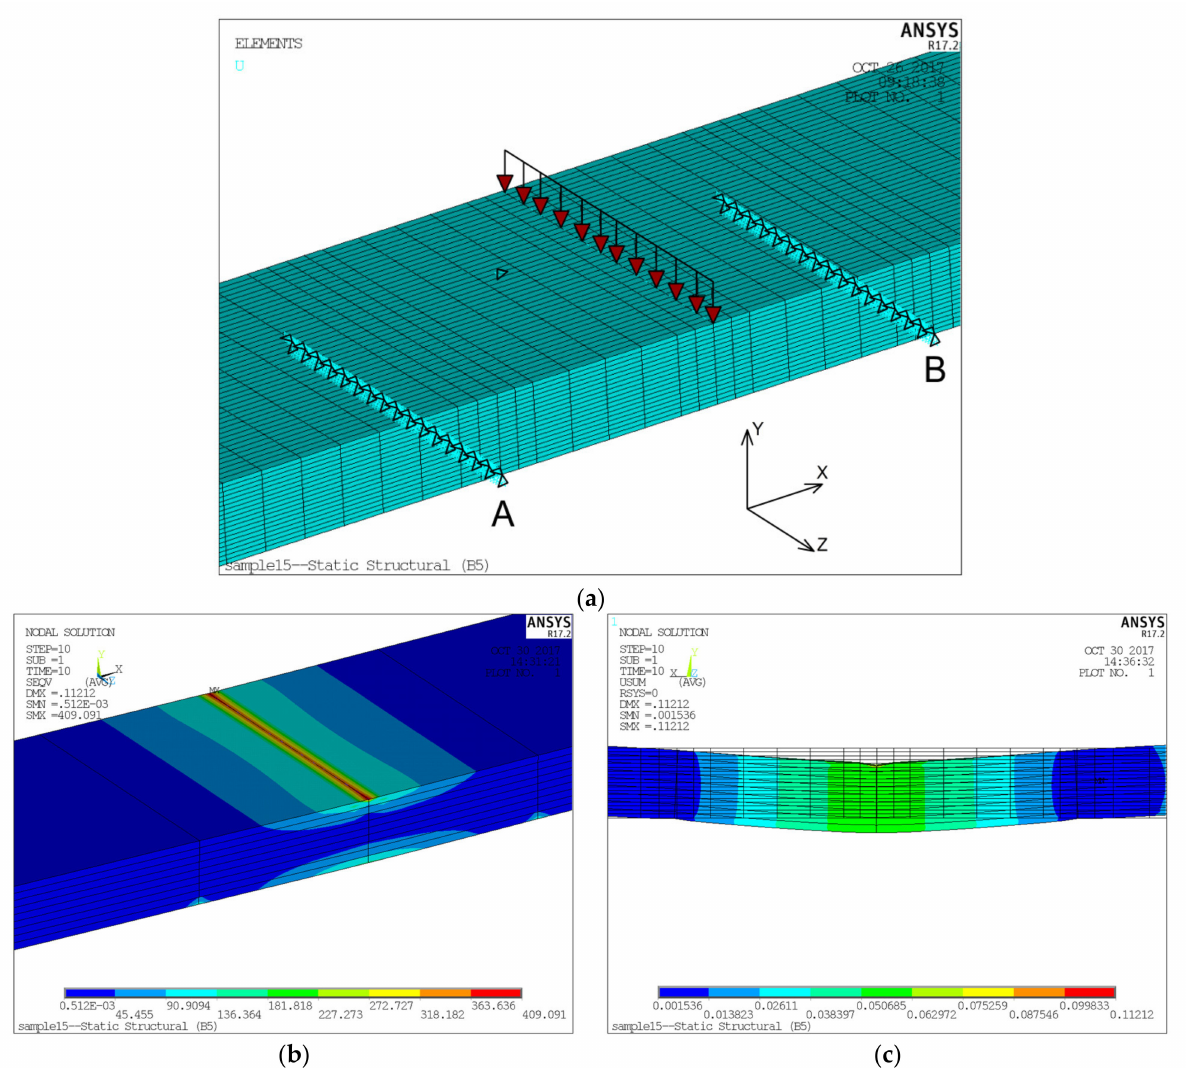
Figure 6. Example of the boundary condition ( a ), equivalent stress ( b ), and bending displacement ( c ) in the calculations of the specimen for interlayer